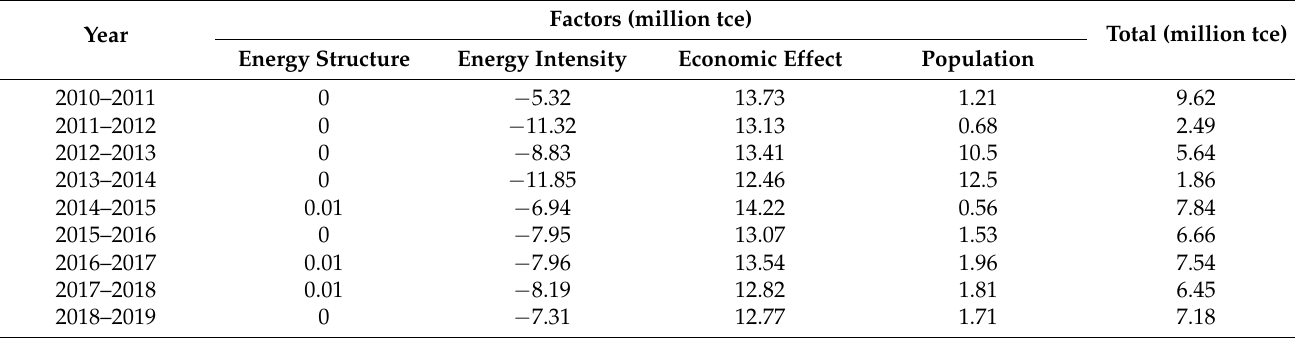
Table 3. The impact of various factors on energy consumption in Zhejiang Province from 2010 to 2019. Factors (million Year